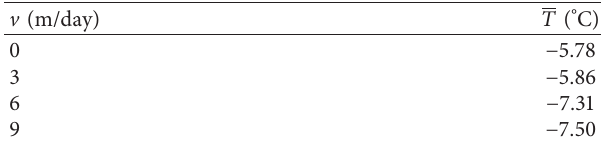
Figure 9: The proportional relationship between the frozen area S under the action of seepage field with a flow rate of (a) 0, (b) 3, (c) 6, and (d) 9m/day. Table 3: The average temperature of the temperature